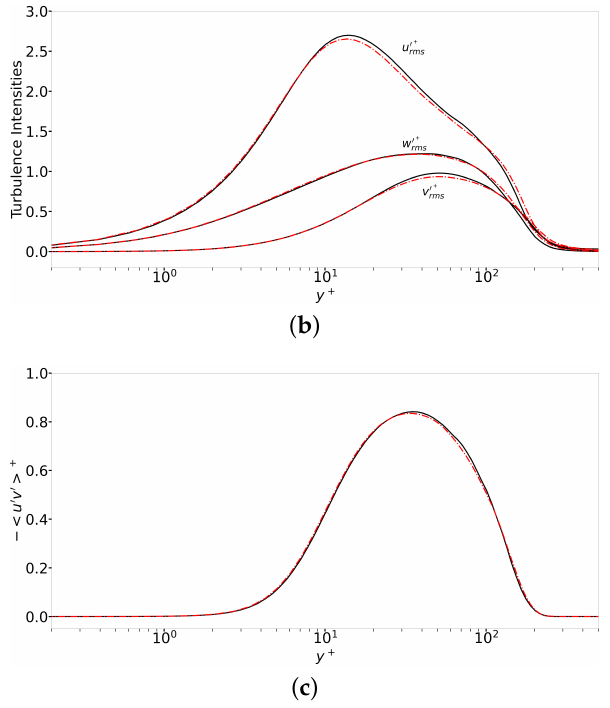
Figure A1. ( a ) Mean streamwise velocity, ( b ) turbulence intensities and ( c ) Reynolds shear stresses in wall units for the ZPG region (unperturbed case).